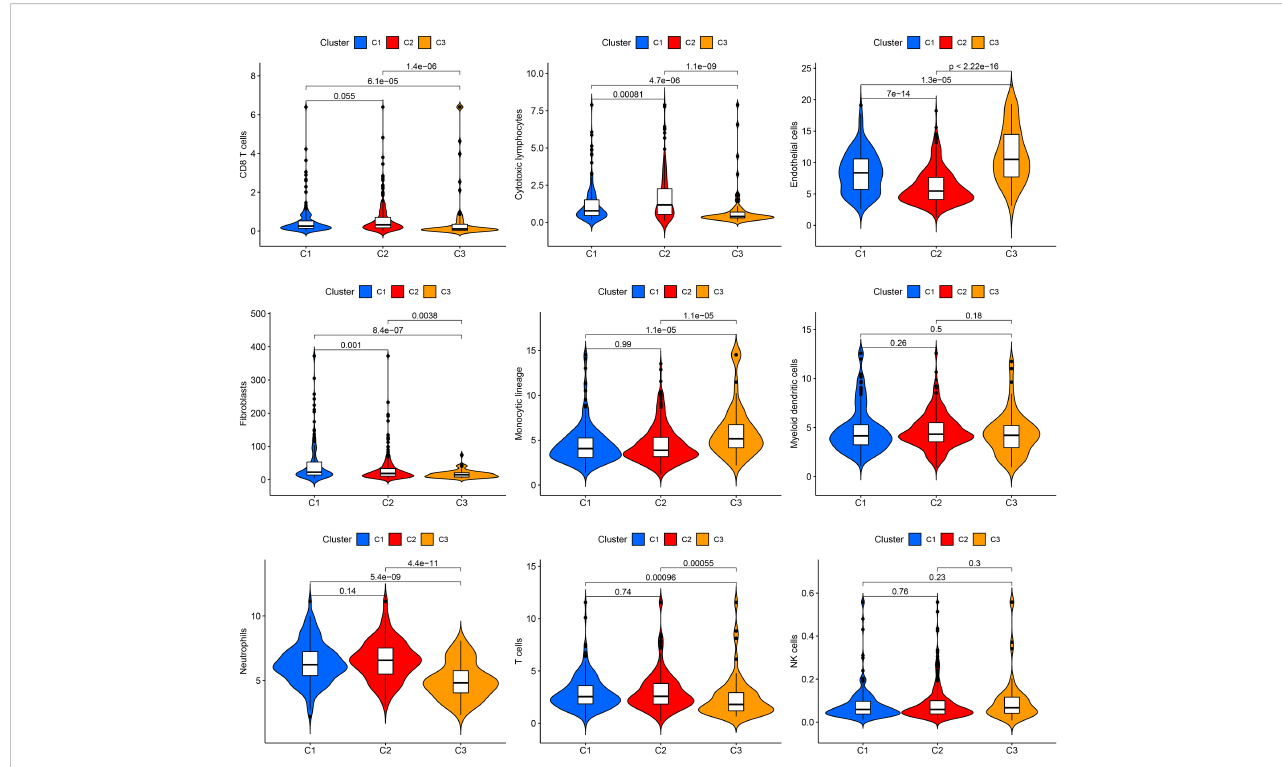
FIGURE 2 Immune cell in fi ltration in the three clusters. Violin plot showing CD8 T cells, cytotoxic lymphocytes, endothelial cells, fi broblasts, monocytic lineage, myeloid dendritic cells, neutrophils, T cells, and NK cells.